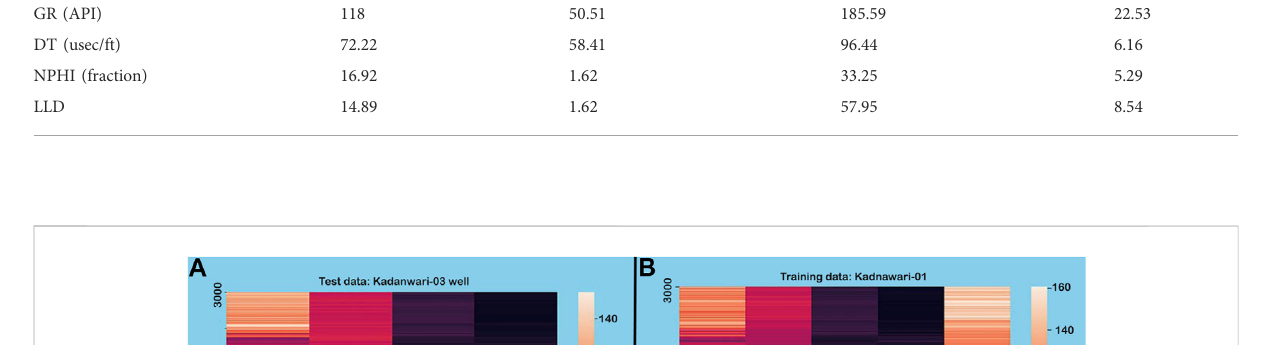
Frontiers in Earth